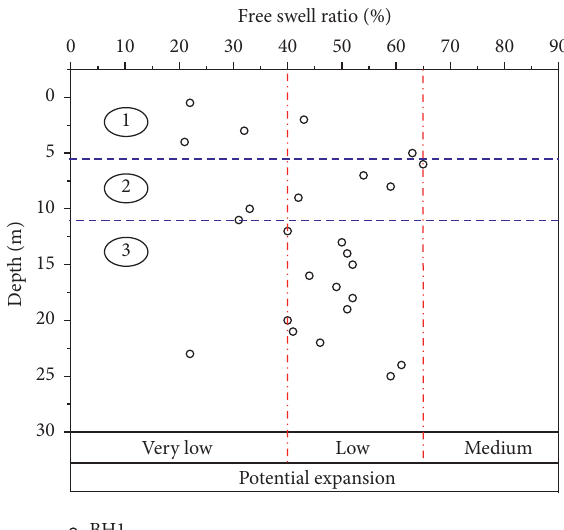
Figure 6: The variation in the free swelling ratio test values with depth at BH1.